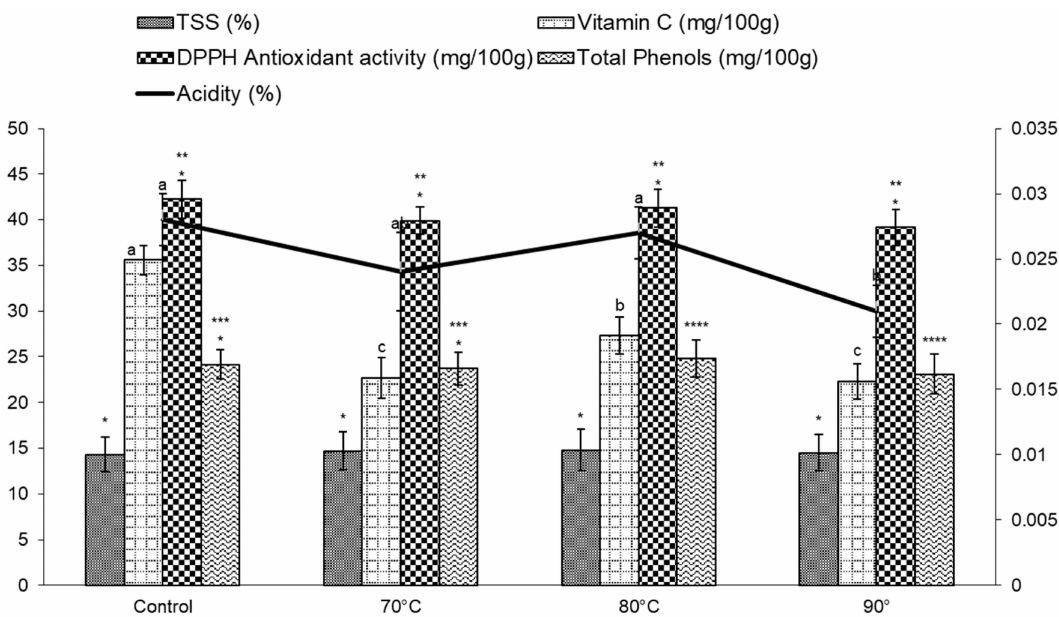
Figure 4. Vitamin C content, DPPH antioxidant activity, and total polyphenolic content of tomato- based pineapple beverage samples thermally treated at 70, 80, and 90 ◦ C. Different number of stars and lower-case alphabets represents significant difference in the values for samples untreated and treated at different